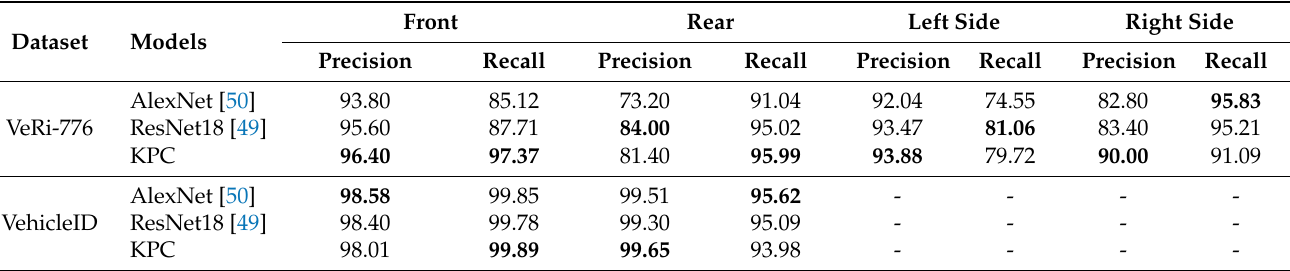
Table 5. Comparisons (%) of the pose classifier on VeRi-776 and VehicleID datasets. The best results are shown in